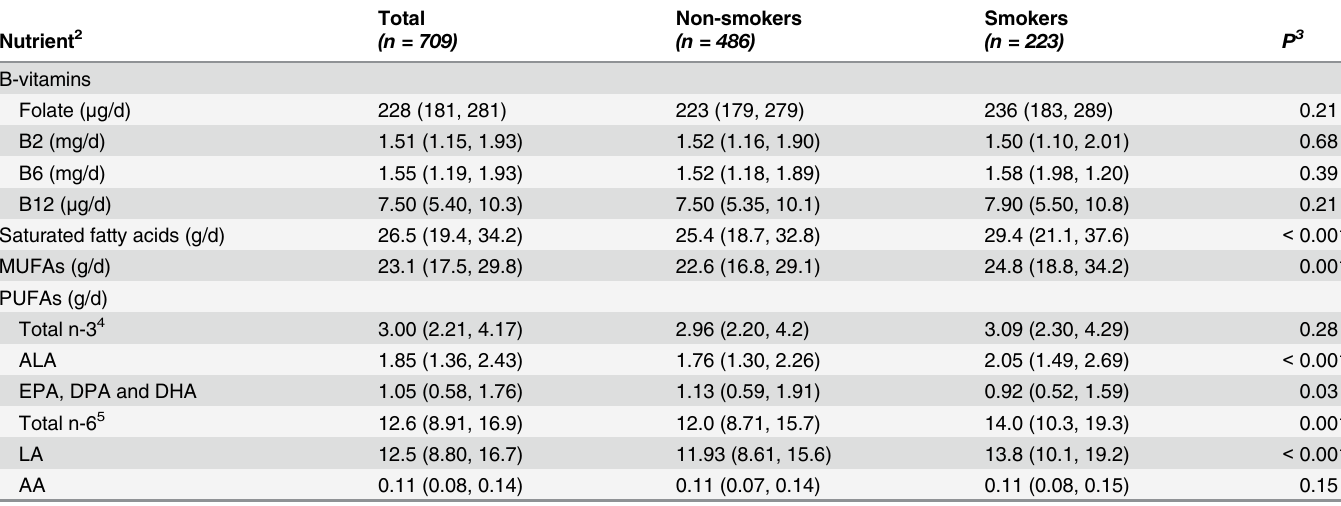
Table 2. Dietary intake of B-vitamins and fatty acids according to smoking status 1